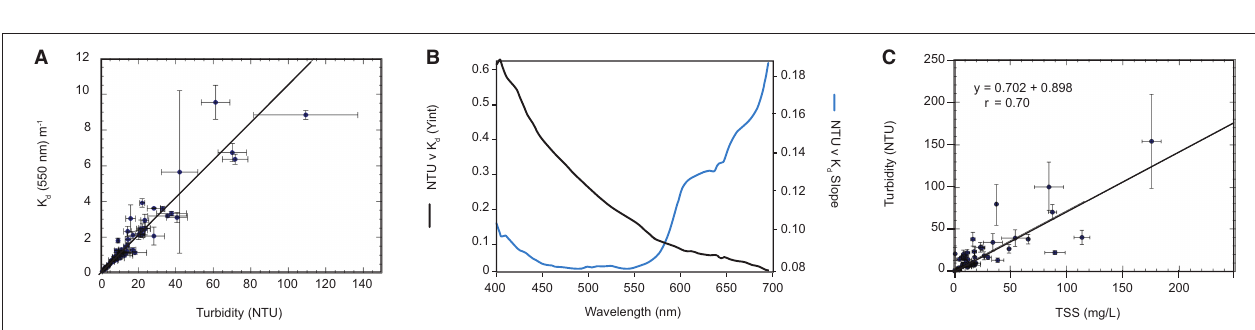
FIGURE 6 | (A) Example regression line of K d (550nm) vs. NTU from the 94 vertical profiles (B) Regression-based spectral NTU-specific K d coefficients (K M ), Regression-based spectral residual K d coefficients (K C ) (C) Surface in-situ NTU average vs. SCC from Niskin samples.